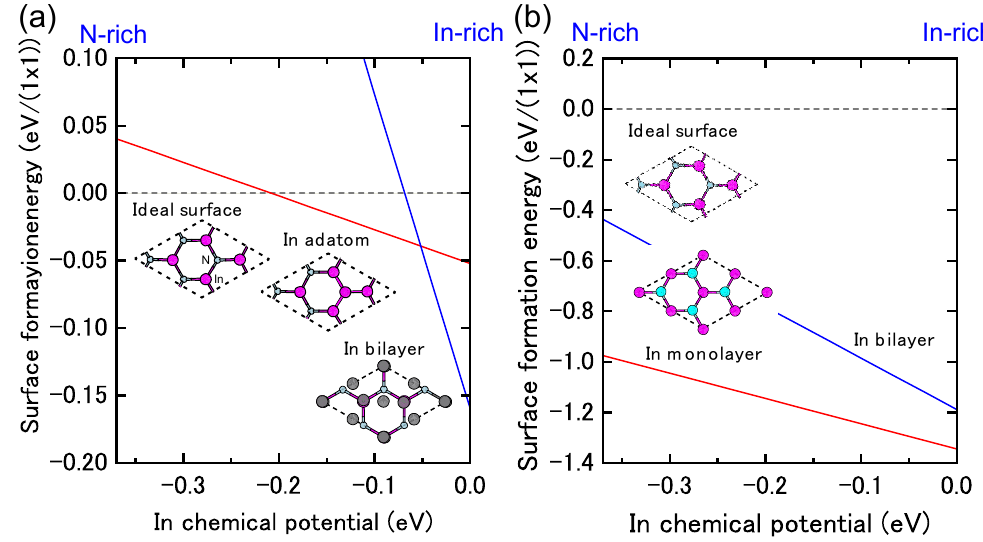
Figure 17. Calculated surface formation energies of polar InN surfaces with ( a ) (0001) and _ ( b ) (0001 ) orientations as a function of In chemical potential. Schematics of the surface structures under consideration are also presented.